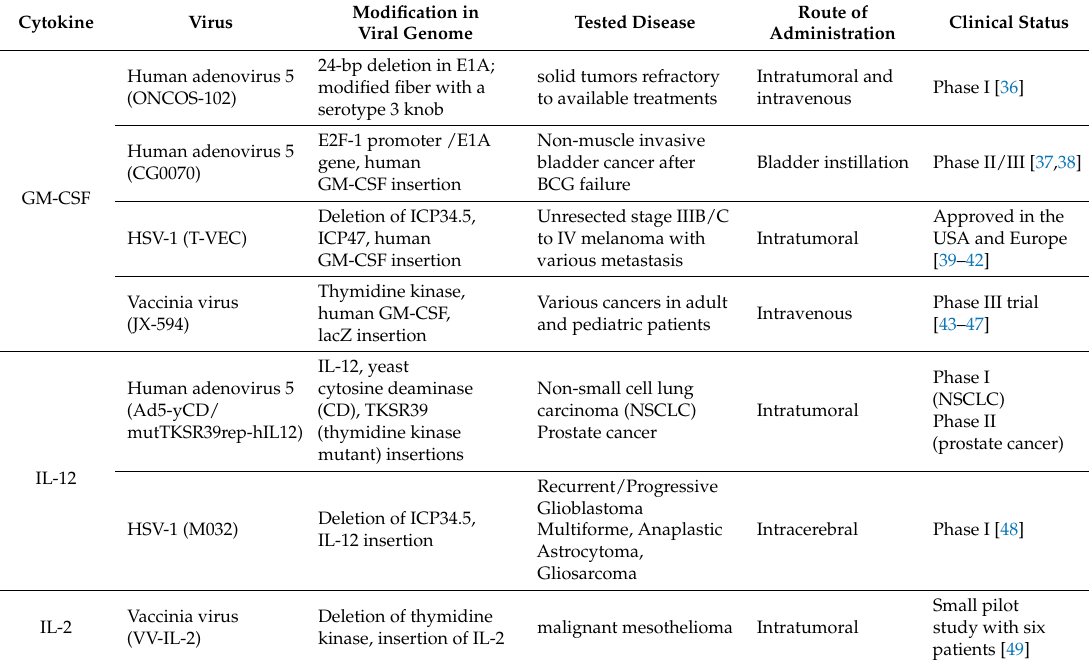
Table 1. Cytokine-armed OVs under clinical